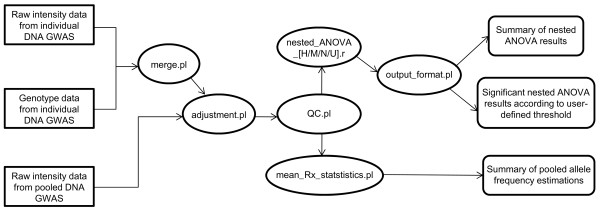
Workflow of UPDG.